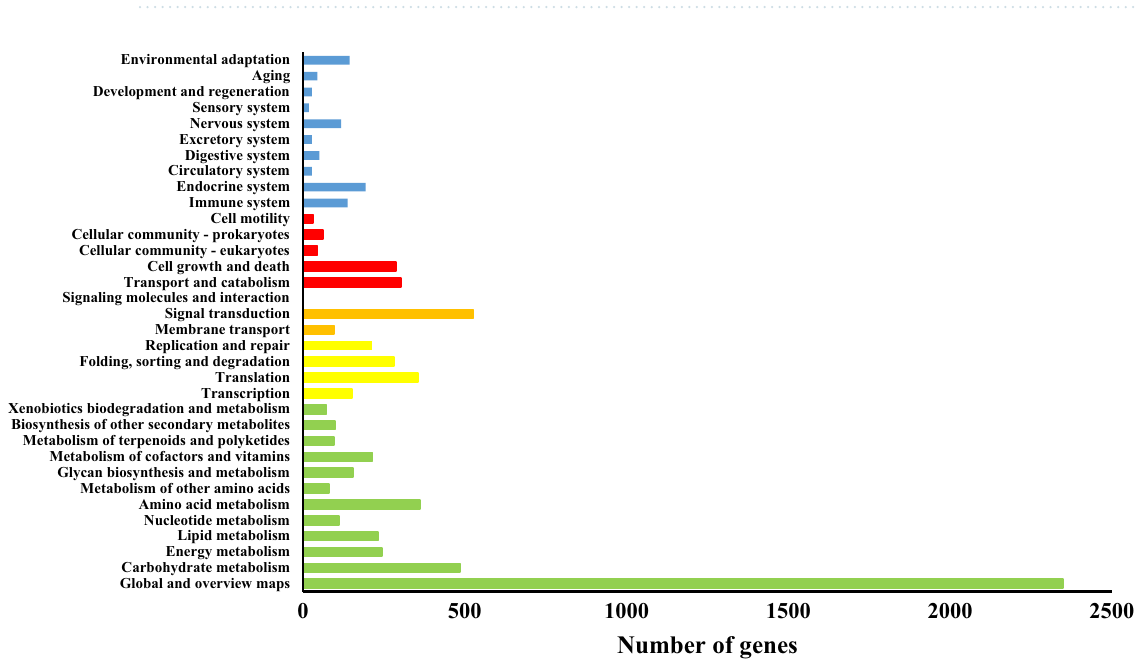
Figure 1. Venn diagram showing the number of differentially expressed transcripts homologous to known annotated genes from KASS, GO, Uniprot KB and NCBI non-redundant (NR) protein databases.